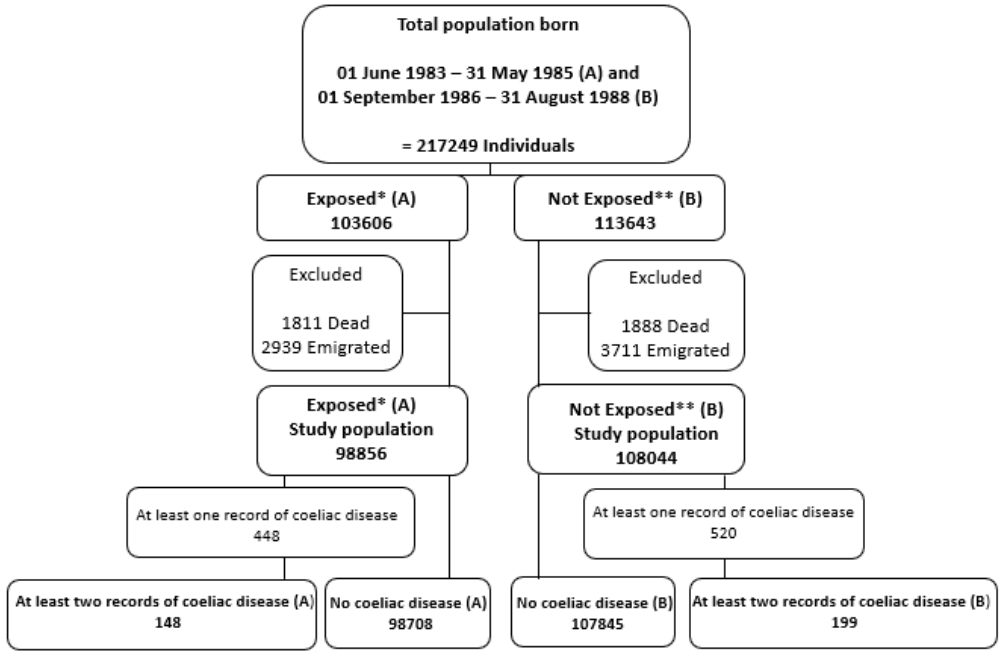
Figure 1. Flow chart of study population. * Exposed: The Danish population was exposed to the Danish vitamin D fortification policy. ** Not Exposed: The Danish population was not exposed to the Danish vitamin D fortification policy.